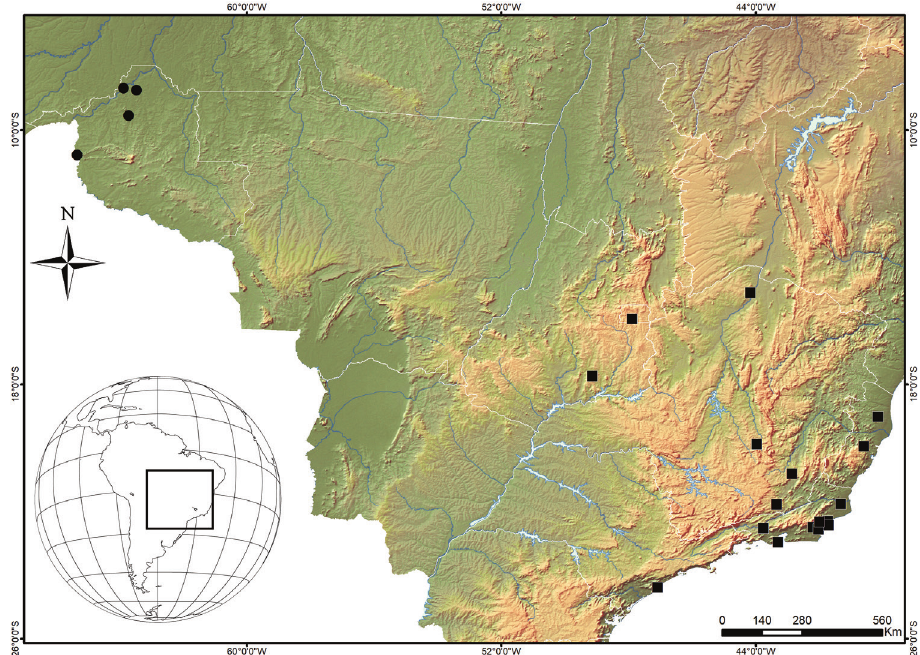
Figure 29. Geographical distribution of the two new species of Diplura . Key: black circles Diplura ma- pinguari sp. n., black squares Diplura rodrigoi sp.